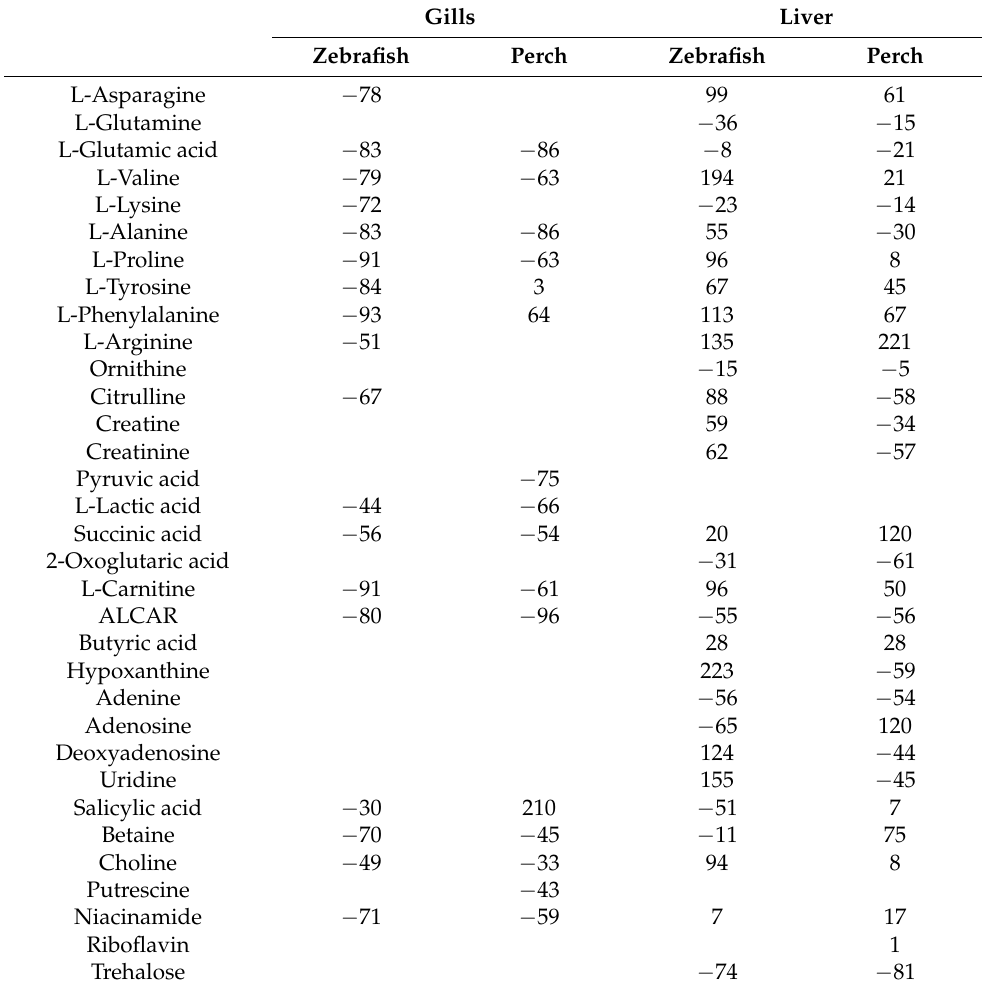
Table 3. Alterations of metabolites levels in gills and liver of exposed fish in comparison to the control, expressed as